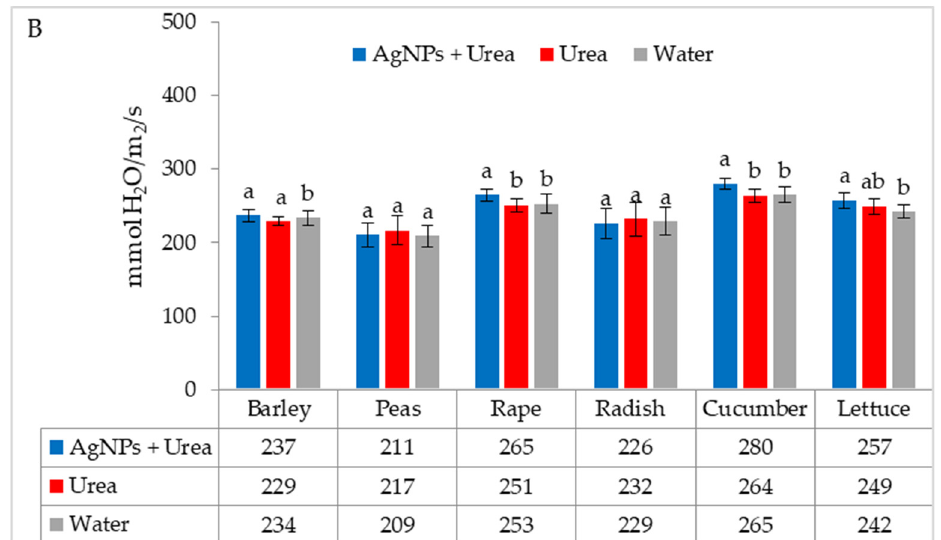
Figure 4. The leaf stomatal conductance of plants under optimal—( A ) and thermal stress conditions—( B ) depending on the presence of AgNPs in the substrate; urea solution with AgNPs (AgNPs + Urea), urea solution (Urea), water (Water). a, b—letters indicate a significant difference in the stomatal conductivity for individual plant species at p < 0.05.